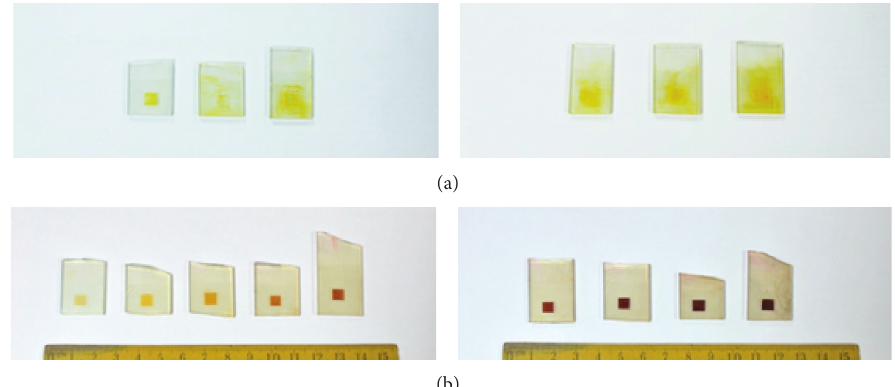
Figure 1: Photos of electrodes after each SILAR cycle (a) of 1–3, 5,7, and 10 cycles for CdS growth and (b) of 1–5 and 7–10 cycles for CdSe growth.